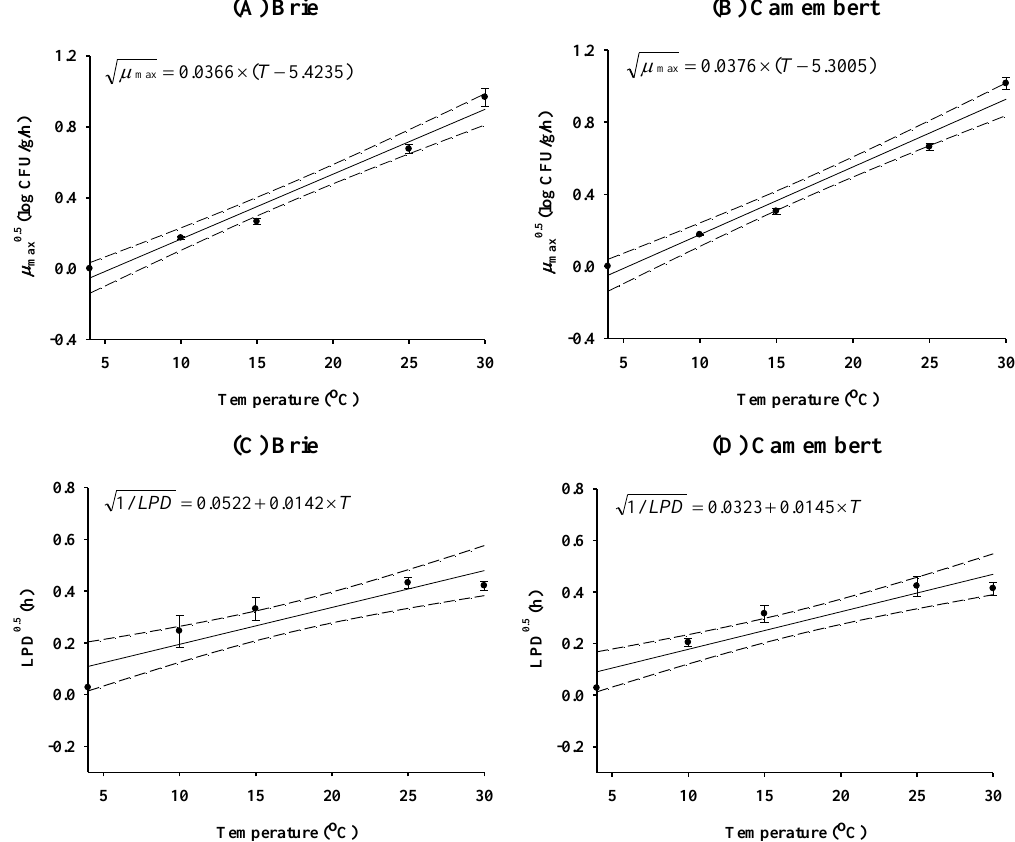
Figure 1. Square root model for  max (A-B) and linear equation for lag phase duration (C-D) developed for Brie and Camembert cheeses. ●, observed value; ―, predicted line; ---, 95% confidence